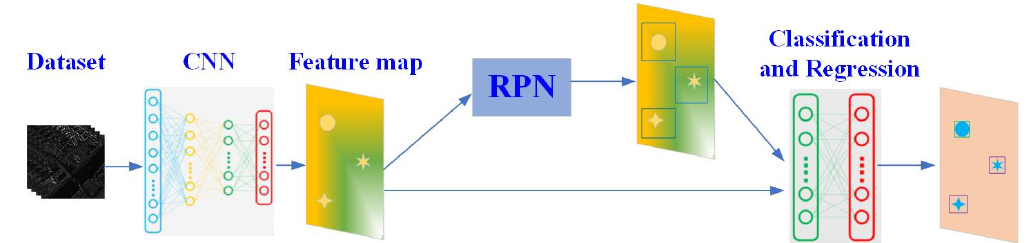
Figure 1. Faster R-CNN architecture.